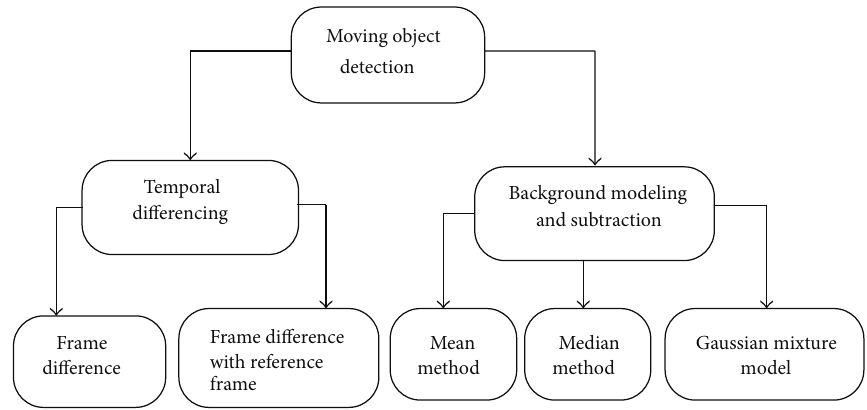
Figure 1: Classification of moving object detection